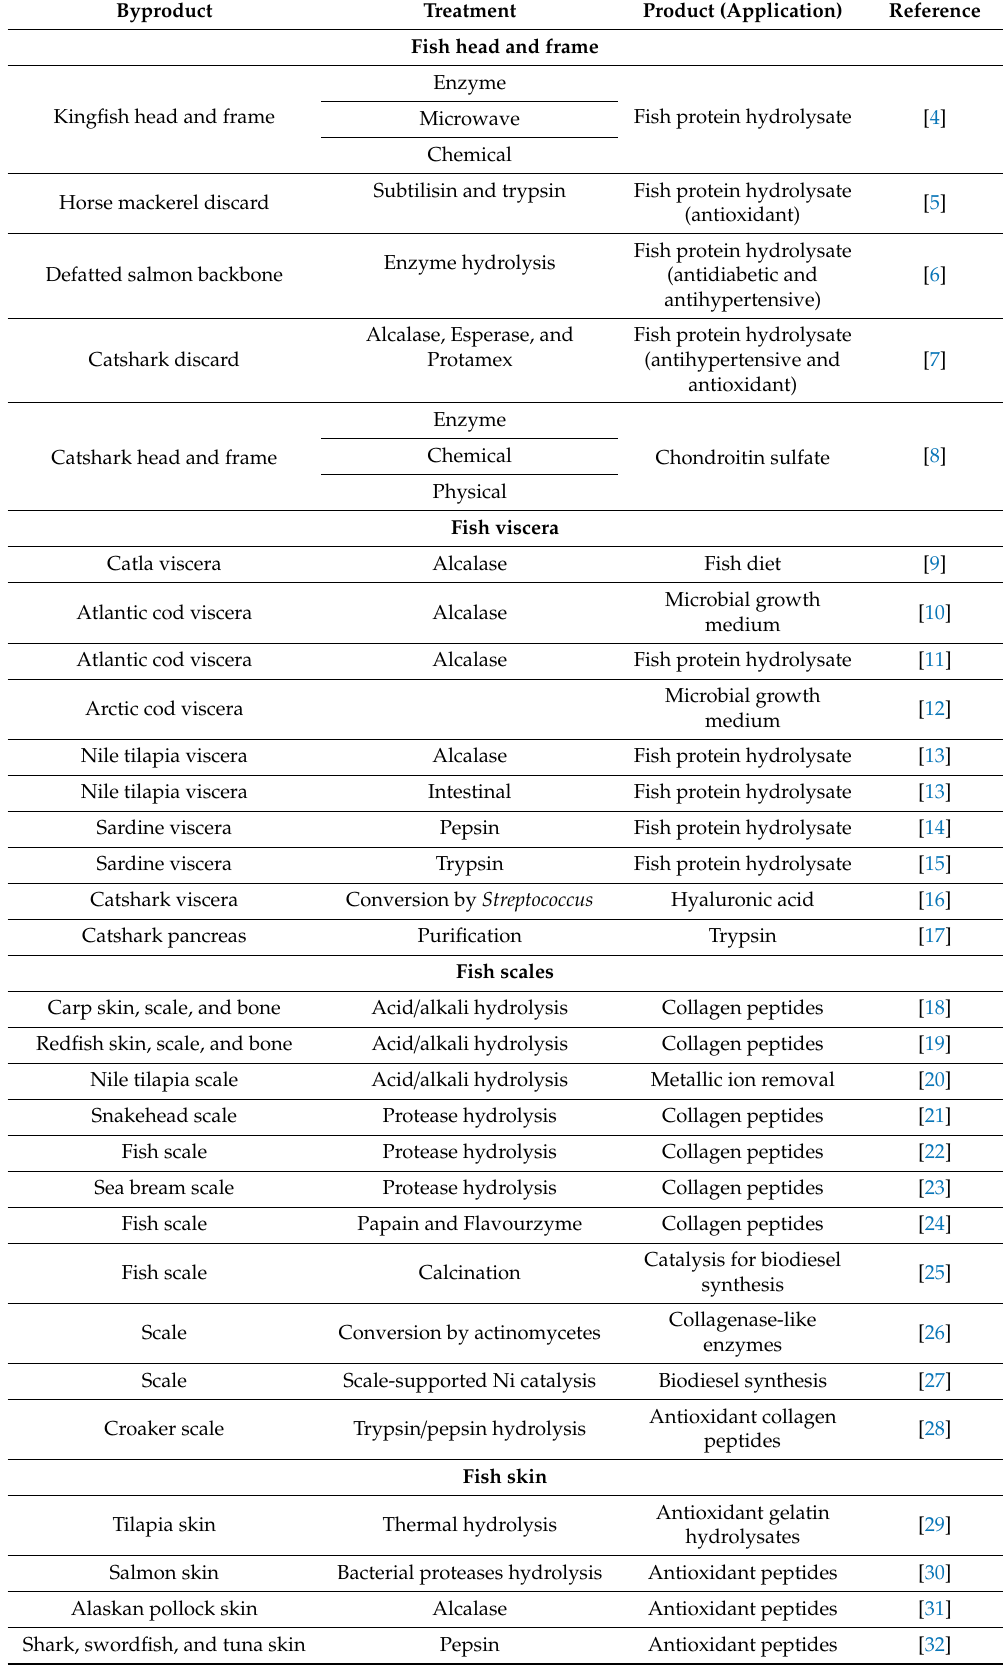
Table 1. Use of fish processing